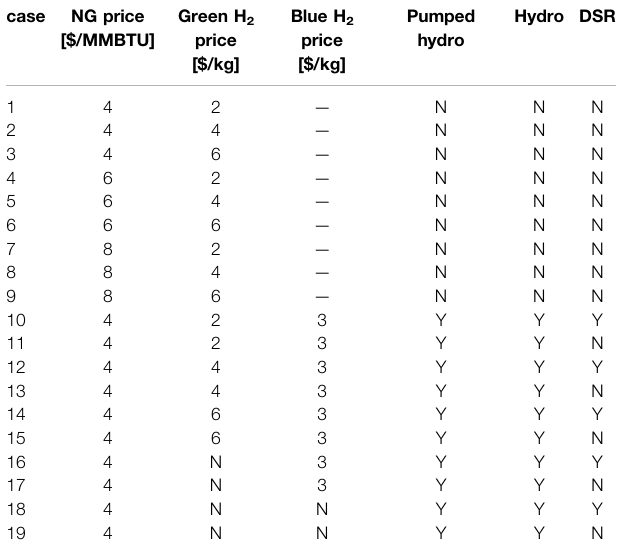
TABLE 1 | Summary of case inputs (Y: included in the scenario: N: not included in the scenario).